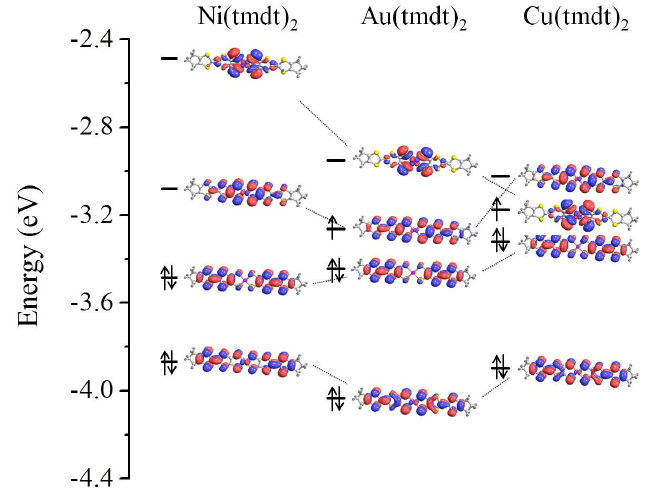
Figure 3. Non-magnetic wavefunctions and energy eigenvalues for planar Ni(tmdt) Au(tmdt) and Cu(tmdt) molecules. Four states including HOMO/SOMO and LUMO are 2 2 shown for each molecule.